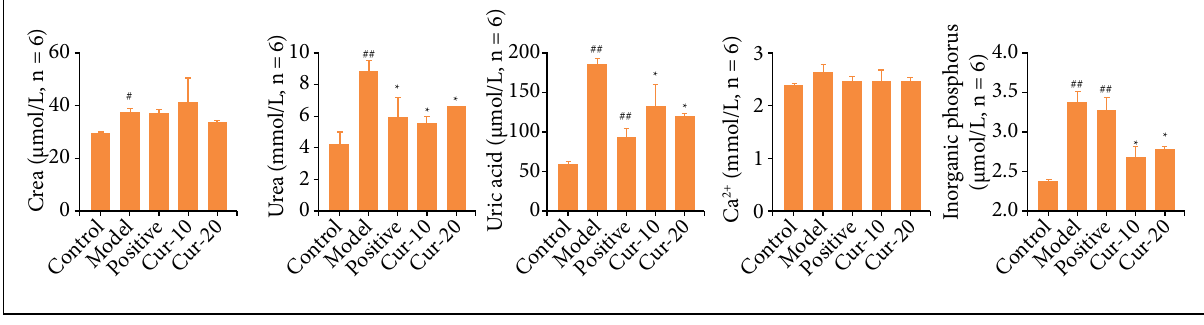
Figure 3 – Serum biochemical test results. Changes of Cr, Ur, UA, Ca 2+ , and IP in serum (n = 6). The normality test was performed using Shapiro–Wilk, differences between two groups were measured by Student’s t-test. * P < 0.05, ** P < 0.01 means comparison with model group, ## P < 0.01 means comparison with the control